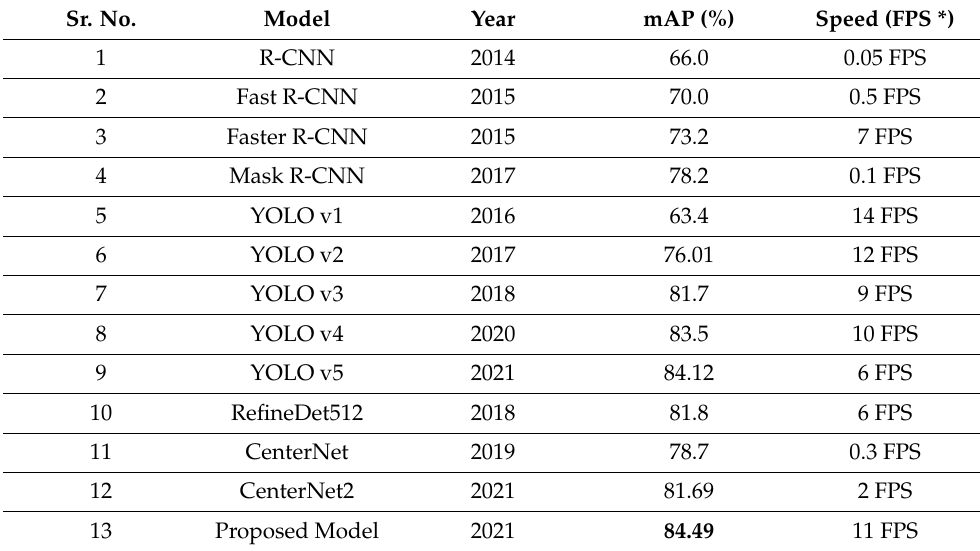
Table 2. Comparison of existing models with a proposed model in terms of mAP and speed. Sr. No.